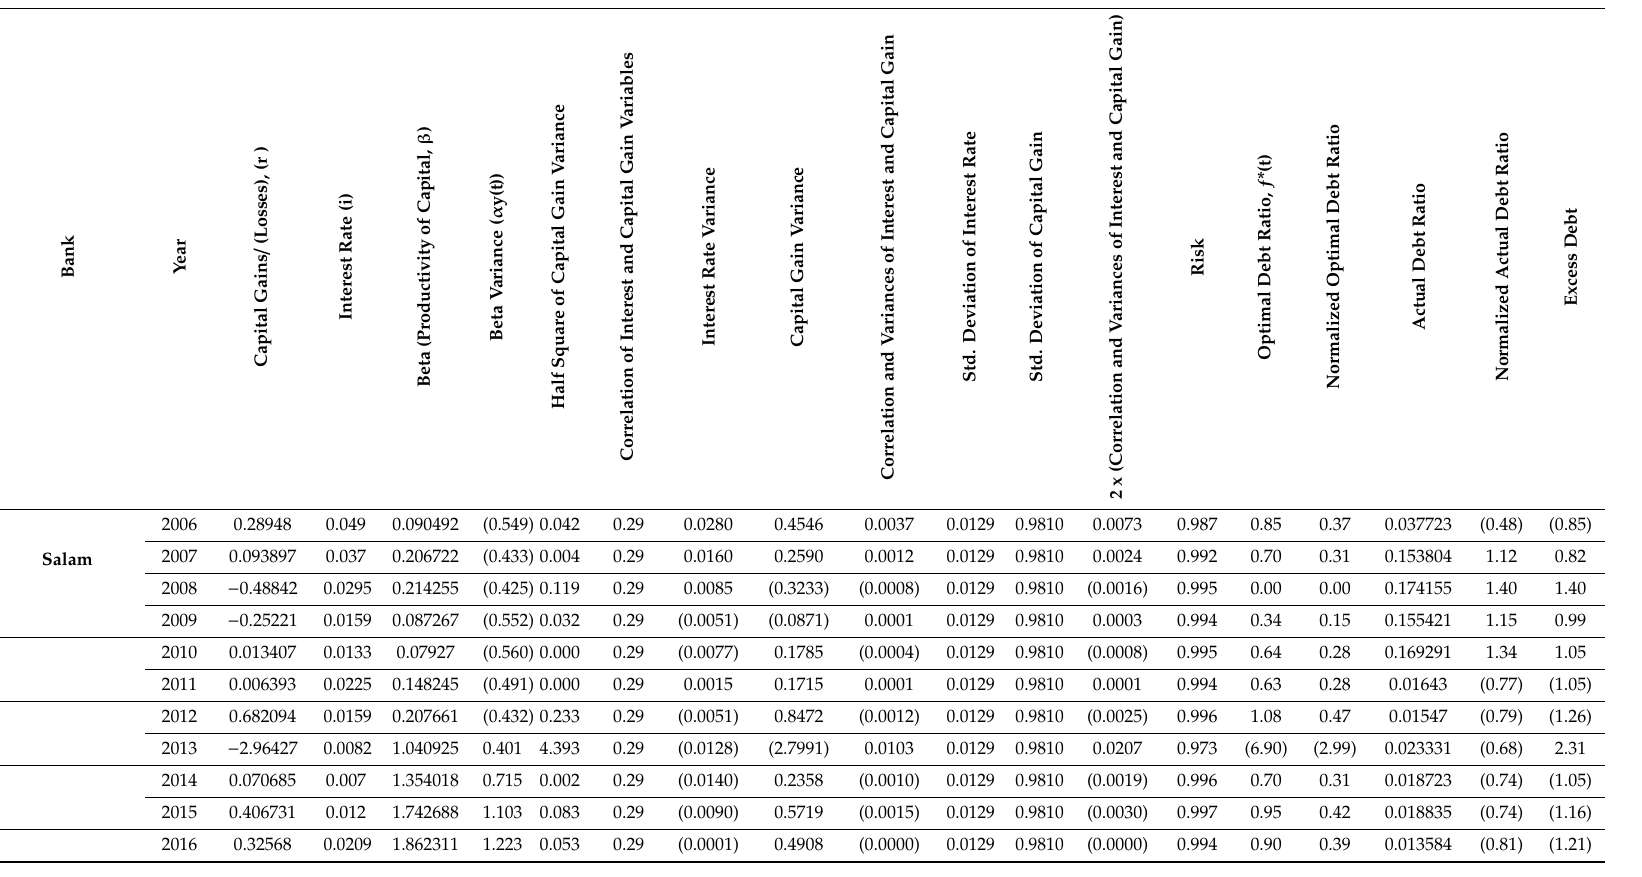
Table A4. Calculations of Optimal and Excess Debt: